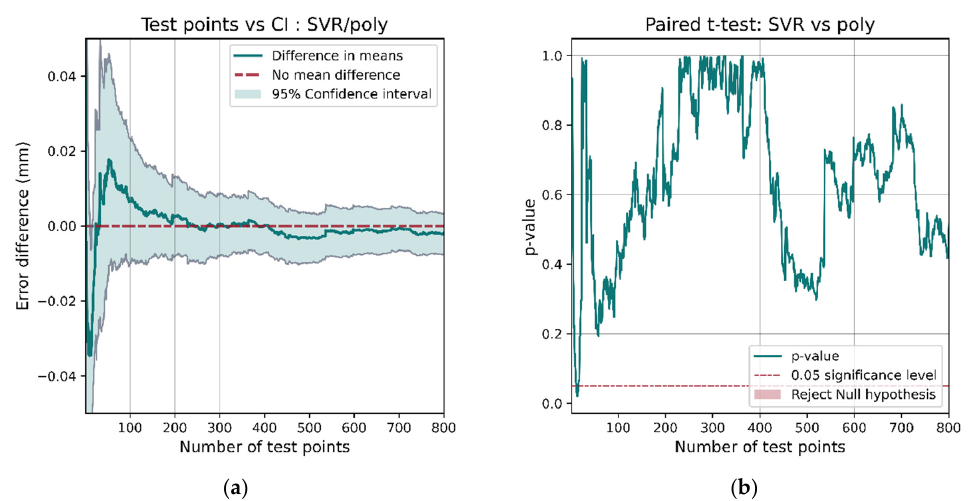
Figure 25. When comparing SVR and polynomial regression, the performance of the models is more similar. The confidence interval ( a ) includes 0 a for a large proportion of the data, and the p -value ( b ) only drops below the 0.05 significance level for a brief period with very few samples.